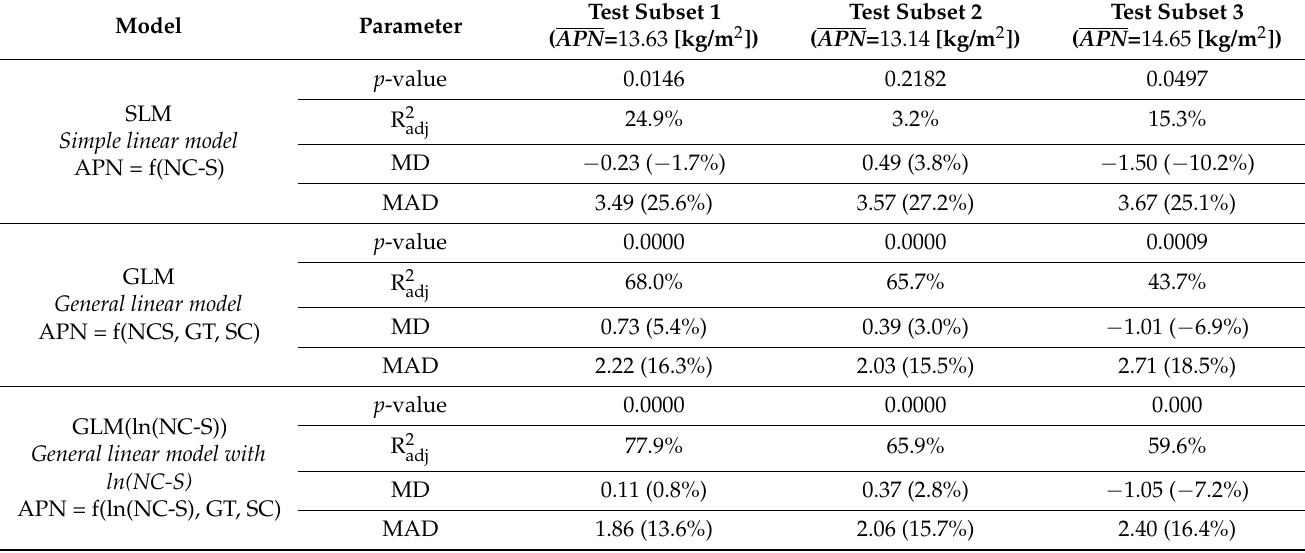
Table 4. Estimation errors of the nodule abundance in three test subsets (of 20 observations each) based on three regression models determined from the training data subsets of 48 observations each); the location of training and test subsets is shown in Figure